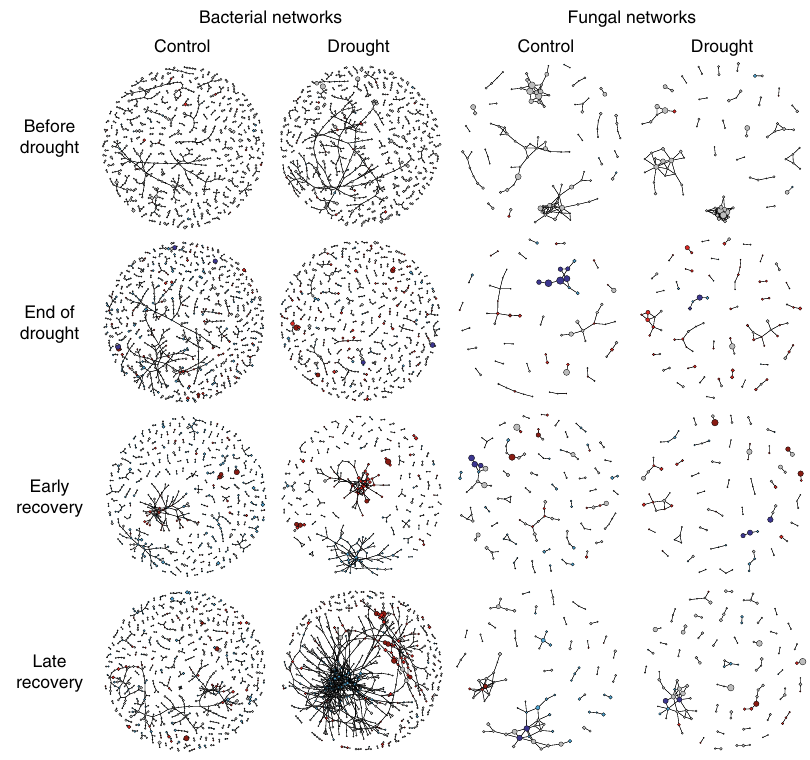
Fig. 4 Bacterial and fungal co-occurrence networks over time as affected by drought. Nodes represent individual OTUs; edges represent signi fi cant positive Spearman correlations ( ρ > 0.6, P < 0.001). Light blue and light red OTUs decrease and increase under drought, respectively; dark blue and dark red OTUs indicate high abundance OTUs that decrease and increase strongly under drought, respectively (drought-sensitive and drought-tolerant indicator OTUs). For detailed network properties, see Supplementary Table